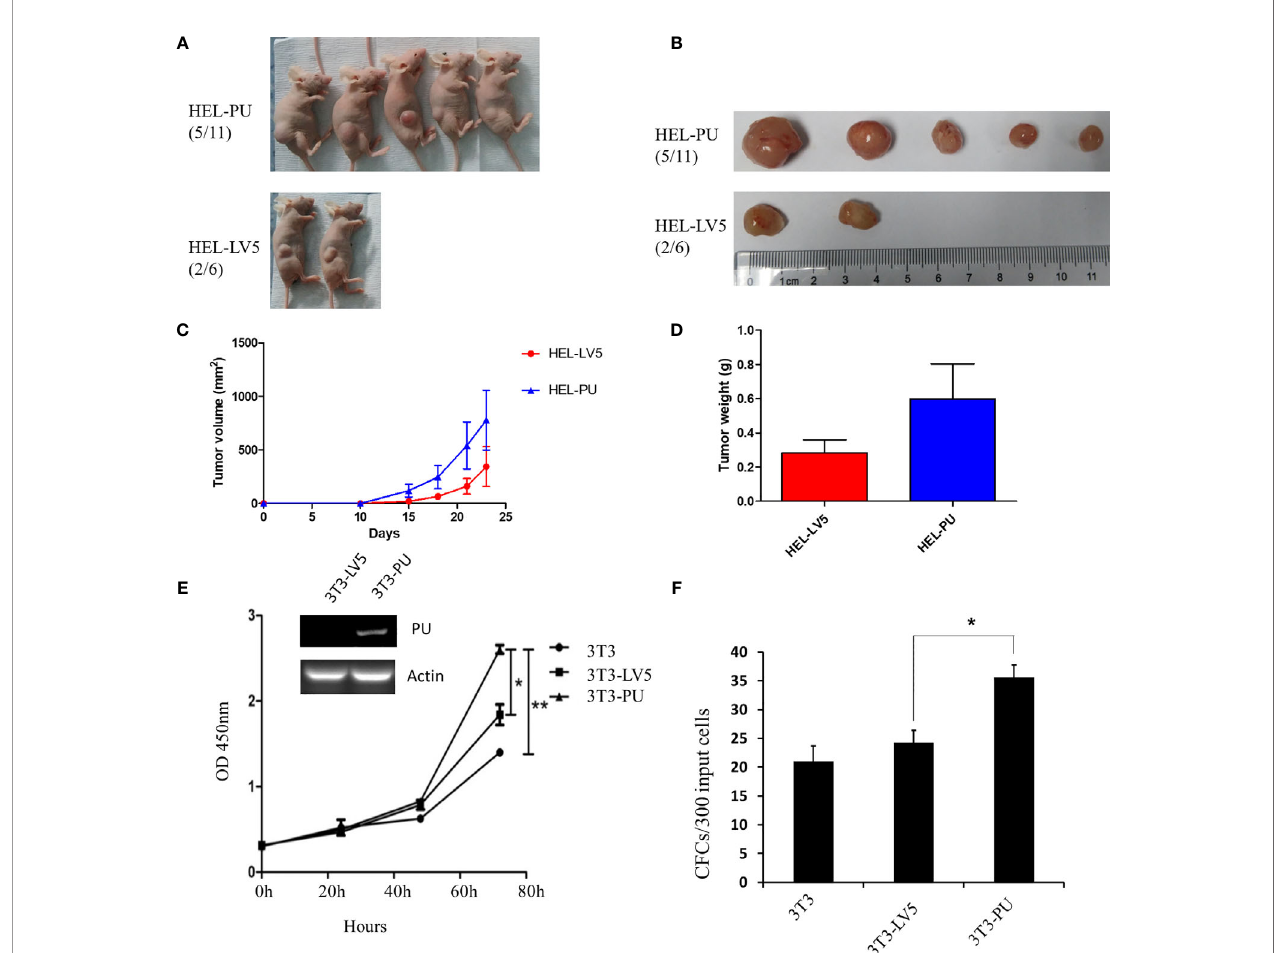
FIGURE 2 | The oncogenic activity of the PAX5-UBE2D4 (PU) fusion. (A) PAX5-UBE2D4 (PU) increases the number of tumors generated by subcutaneous injection of HEL cells into nude mice. (B, C) The sizes of the tumor masses and tumor weights (D) after injection of HEL cells expressing the indicated genes. (E) PU fusion promotes the proliferation and colony formation (F) of NIH-3T3 cells. P values are from Fisher ’ s exact test. *P < 0.05, **P <